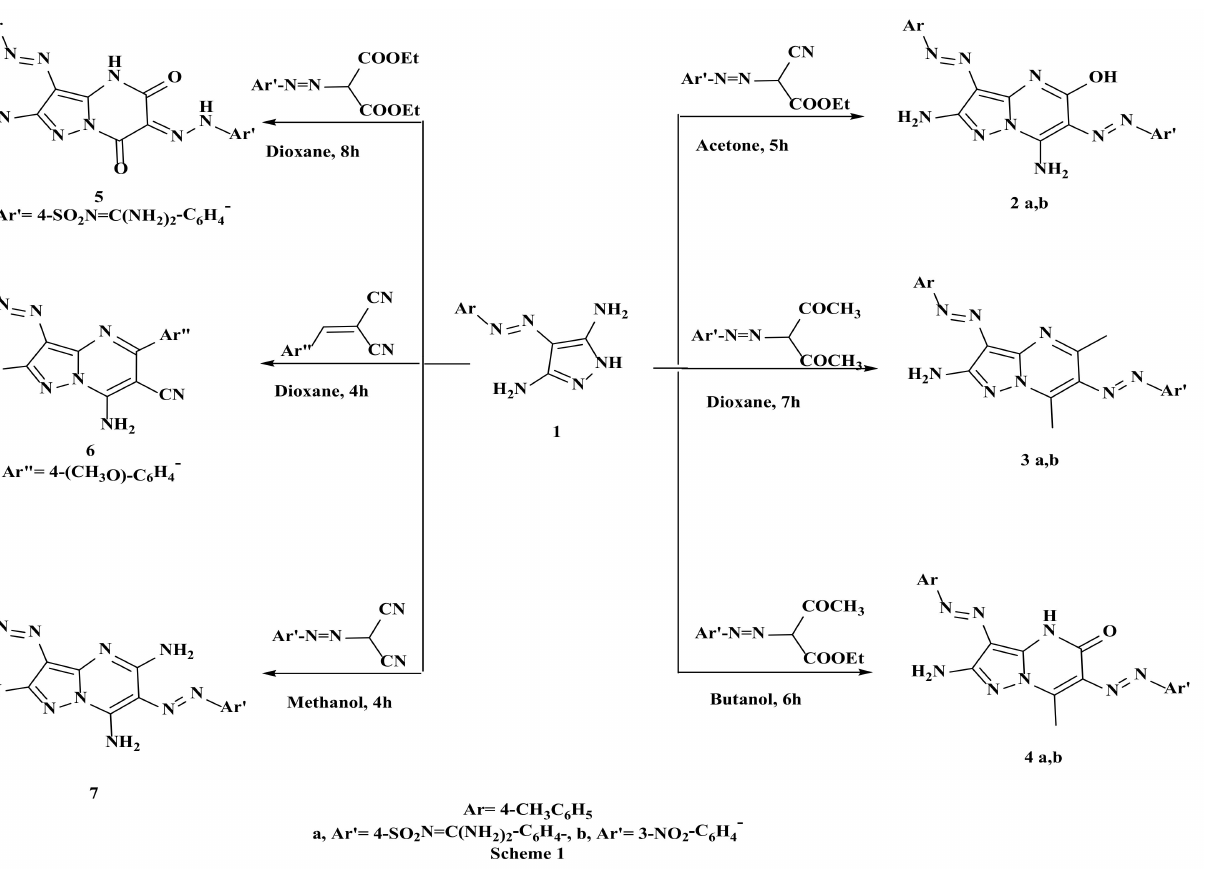
Scheme 1. Synthesis of target pyrazolopyrimidine